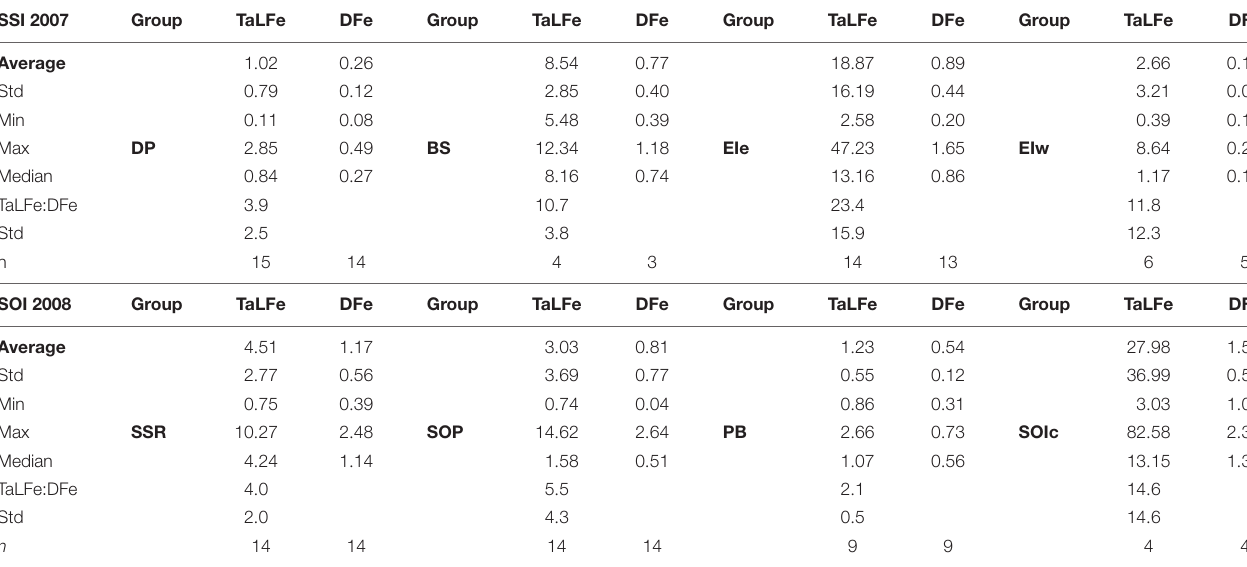
TABLE 2 | Descriptive statistics and TaLFe to DFe ratio for all the groups of stations within the SSI and SOI. Concentration in